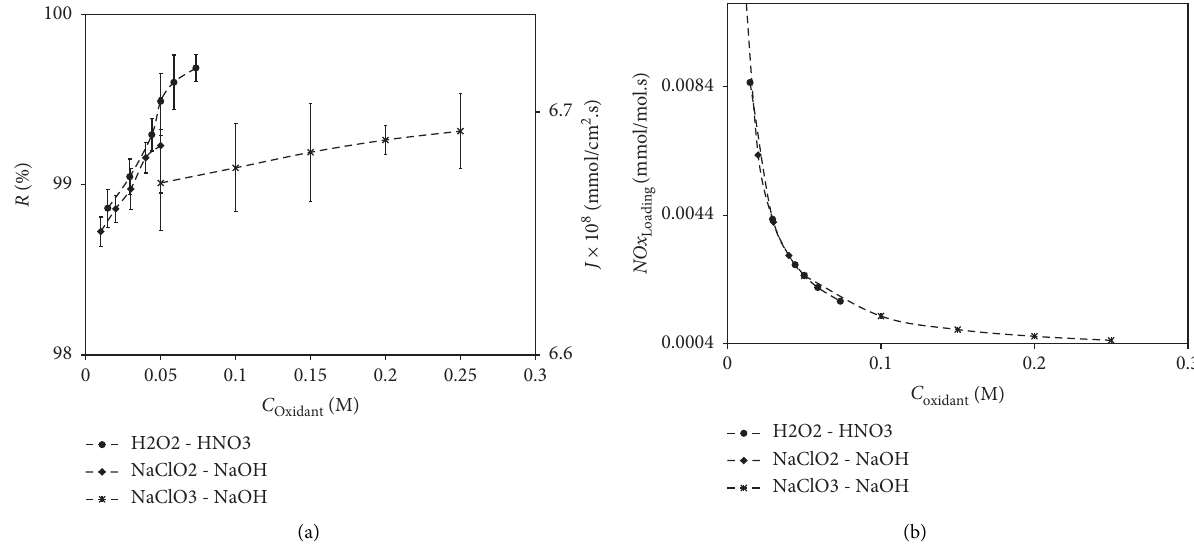
Figure 7: The fiber in the membrane module, n F , on (a) the NOx expulsion efficiency, R , and the flux, J ; (b) the NOx loading in a membrane module containing 400mL of absorbent pairs of H 2 O 2 (0.05 M) - HNO 3 (0.25 M), NaClO 2 (0.05 M) – NaOH (0.25 M), and NaClO 3 (0.05 M) – NaOH (0.25 M) at the feed gas flow rate of